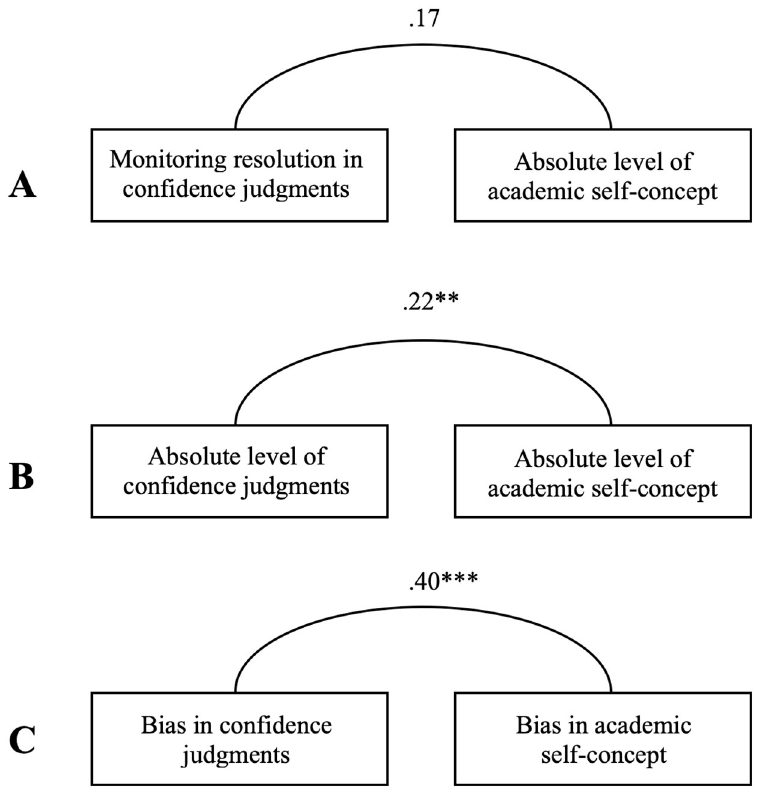
Fig 1. Relations between various measures of confidence judgments and self-concept. A = Relation between monitoring resolution and absolute level of academic self-concept; B = Relation between absolute level of confidence judgments and absolute level of academic self-concept; C = Relation between monitoring bias and academic self- concept bias; �� = p < .01; ��� = p < .001.